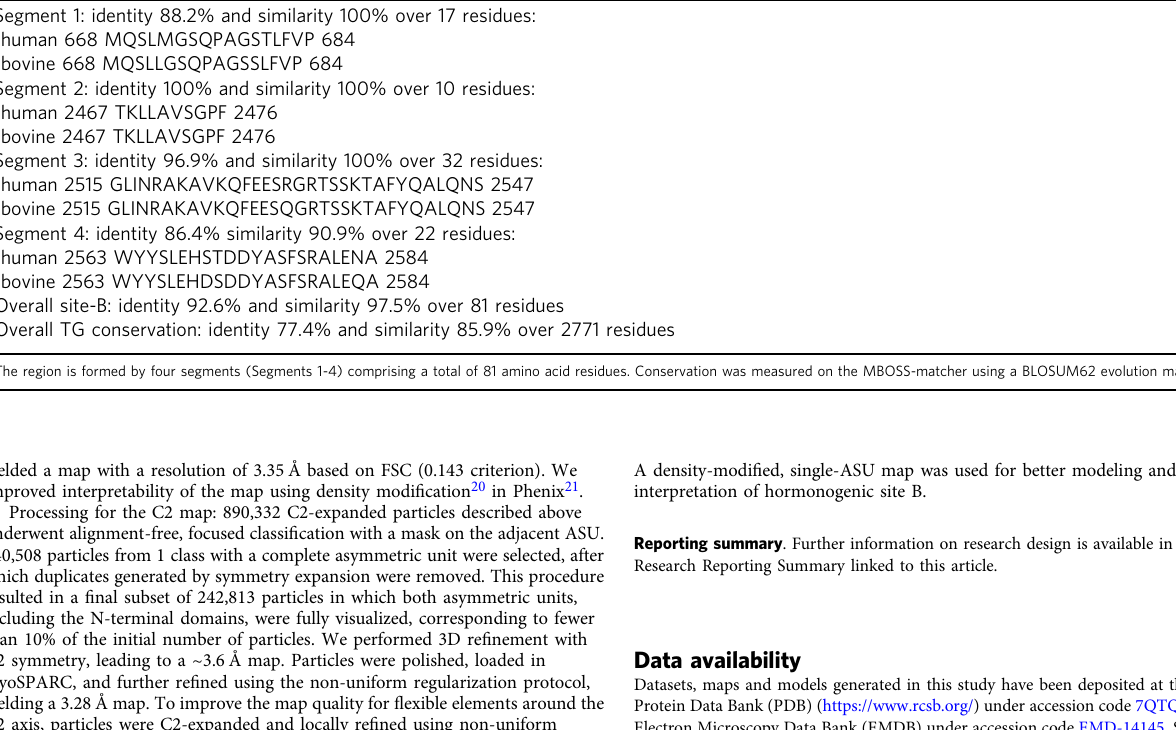
Received: 19 October 2021; Accepted: 13 April 2022;